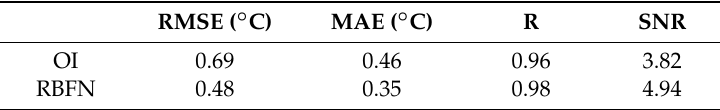
Figure 7. ( a ) root mean square error (RMSEs); ( b ) mean absolute error (MAEs); ( c ) Pearson correlation coefficient (Rs) and ( d ) signal-to-noise ratio (SNRs) of the reconstructed SSTs from the optimum interpolation (OI) and RBFN methods in the study region during the period from 12 June to 18 June 2014. Table 3. Statistical results from the OI and RBFN